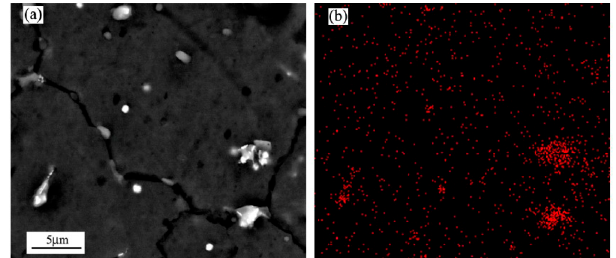
Figure 7. FE-SEM of the spray-casted AZ91D+0.75Ce alloy after being annealed at 420 ° C for 8 h: ( a ) Field emission scanning electron micrograph; ( b ) the distribution of Ce element.